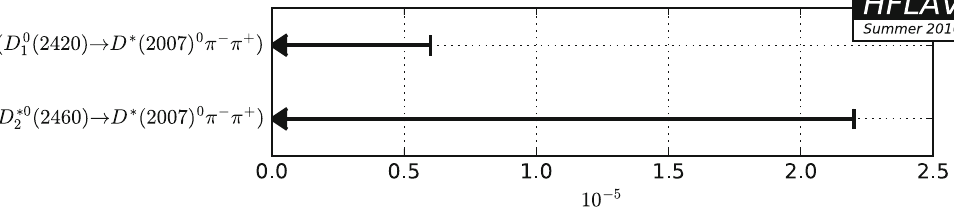
Fig. 112 Summary of the averages from Table 142